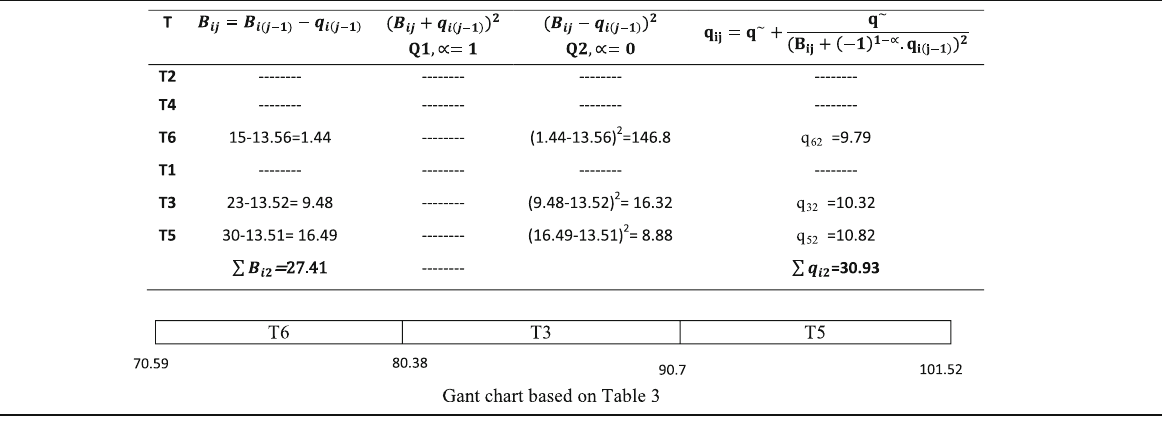
Table 3 Task quantum calculations in the second round